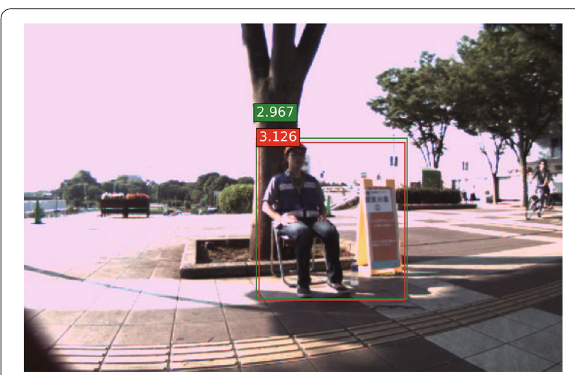
Fig. 19 Examples of estimated distance for the front-view of the target object in Tsukuba Challenge. The ground truth distance and estimated distance are written in green and red boxes respectively.